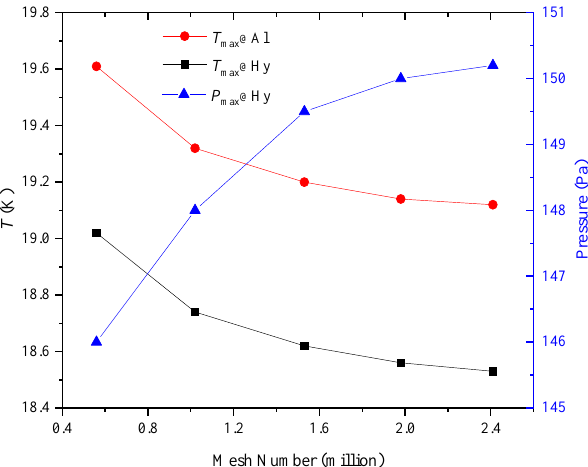
Figure 6. Mesh independence verification for Coupled Hydrogen Moderator (CHM).